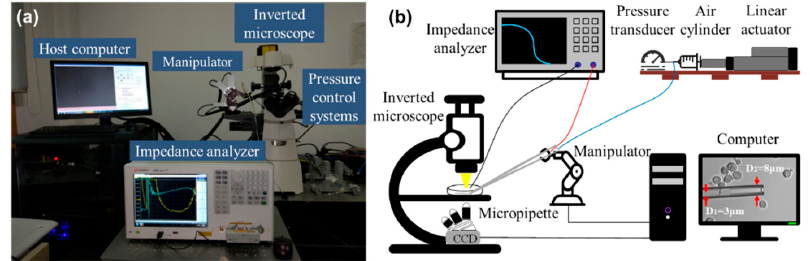
Figure 1. Setup of the whole system showing its key components including the micromanipulator, pressure controller, and the impedance analyzer. ( a ) A photo of the micropipette system; ( b ) schematic of the micropipette system.